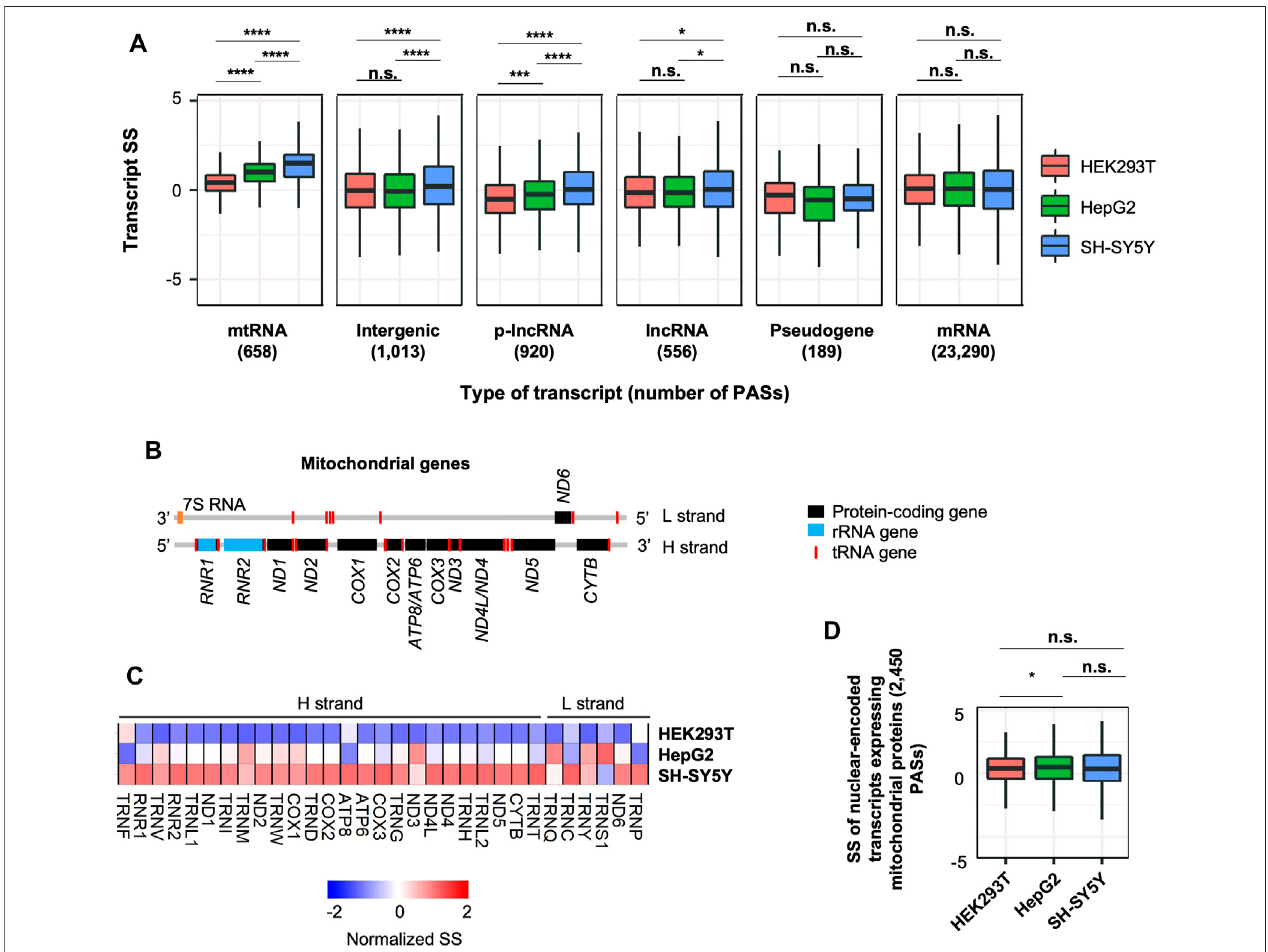
FIGURE6| DistinctstabilitycontroloflncRNAsandmitochondrialRNAsinSH-SY5Ycells. (A) BoxplotsshowingSSofdifferentRNAspeciesin3 celllines. p -value (Wilcoxon test)forsigni fi cance ofdifferencebetweencell lines isindicated. Onlythe transcripts detected inallcell lines areincluded,and only theRNAspecies with > 100 detectedtranscriptsareshown.n.s., p > 0.05;*, p ≤ 0.05;**, p ≤ 0.01;***, p ≤ 0.001;****, p ≤ 0.0001. (B) Schematicoftranscriptsexpressedfromheavy(H)andlight(L) strands of the mitochondrial genome. (C) Heatmap showing normalized SS of mitochondrial transcripts in 3 cell lines. (D) SS of nuclear-encoded transcripts that encode mitochondrial proteins in 3 cell